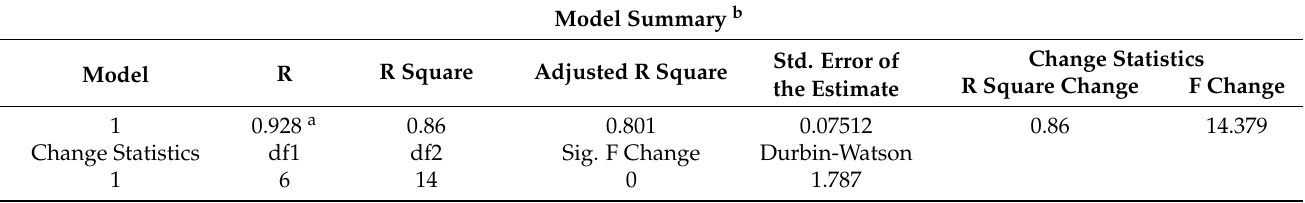
Table 3. The model of analysis for Bulgaria during